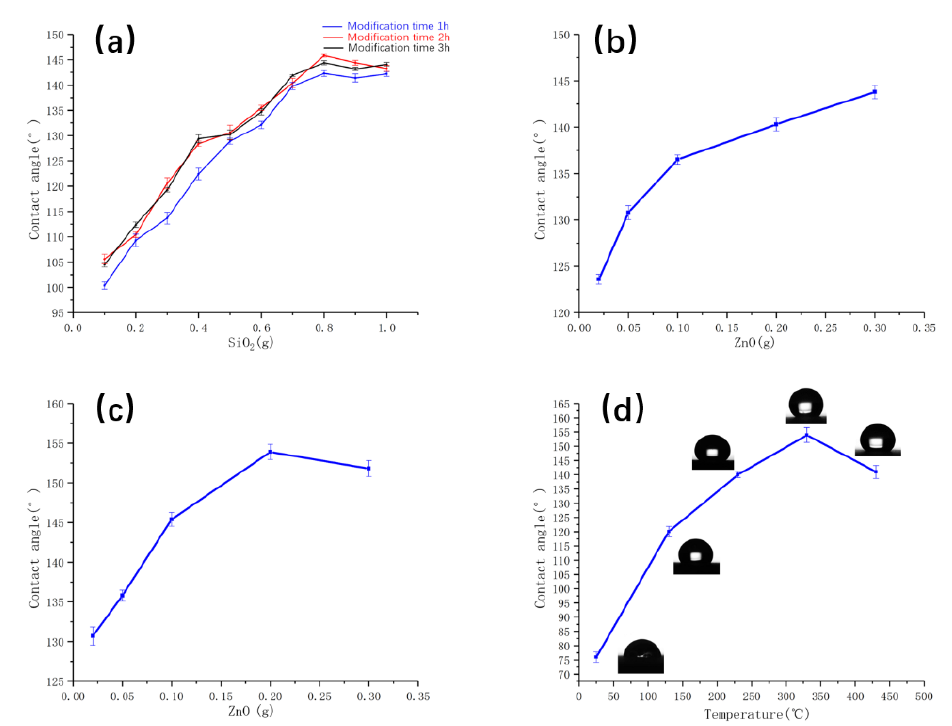
Figure 3. ( a ) CAs at different modification times and different SiO 2 additions, ( b ) CA under different ZnO addition conditions, ( c ) Silicon dioxide 0.8 g, CA for different ZnO addition conditions, and ( d ) CAs of coatings at different temperatures.